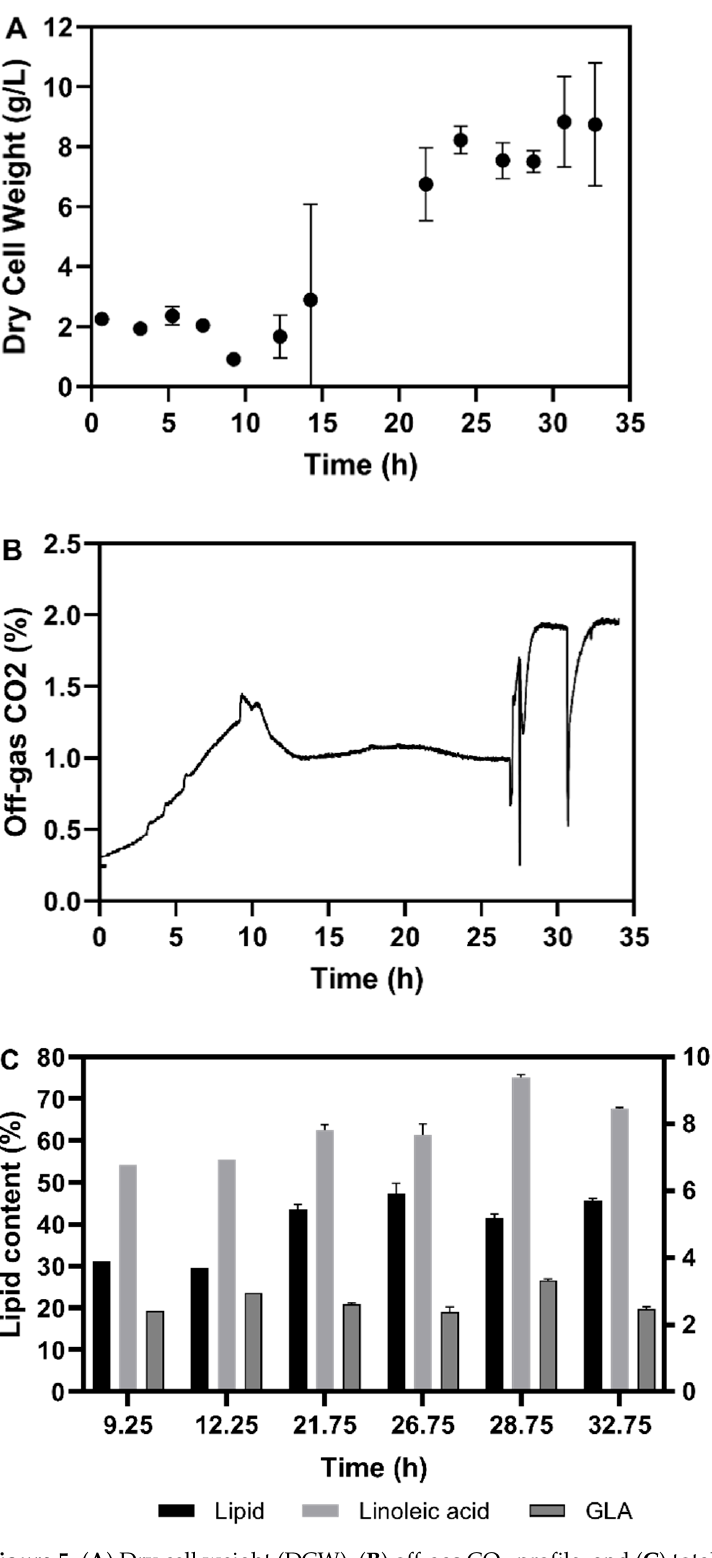
Figure 5. ( A ) Dry cell weight (DCW), ( B ) off-gas CO 2 profile, and ( C ) total lipid content (% wt of dry cell weight), linoleic acid, and GLA (% wt of total lipid weight) obtained during batch cultivation of M. circinelloides in fermenter using animal fat rest materials.